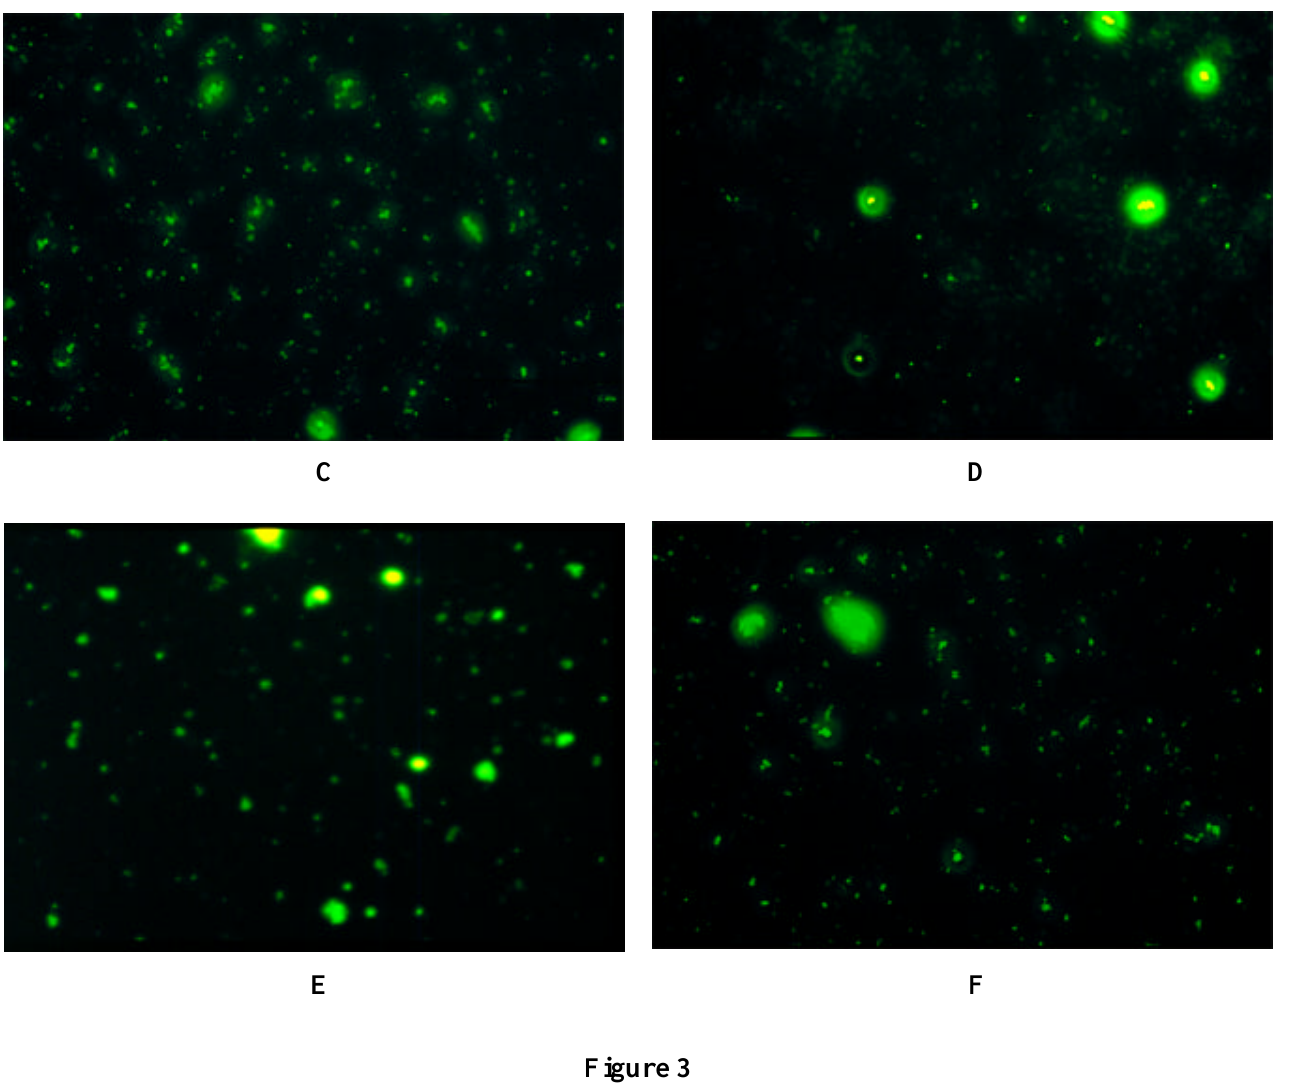
Binding of the antibody Y E2/Eto BHK cells (Y ): A) Normal conditions; B) Blocking 5 5 E2/E with a peptide concentration of 10 -4 of the antibody Y 1